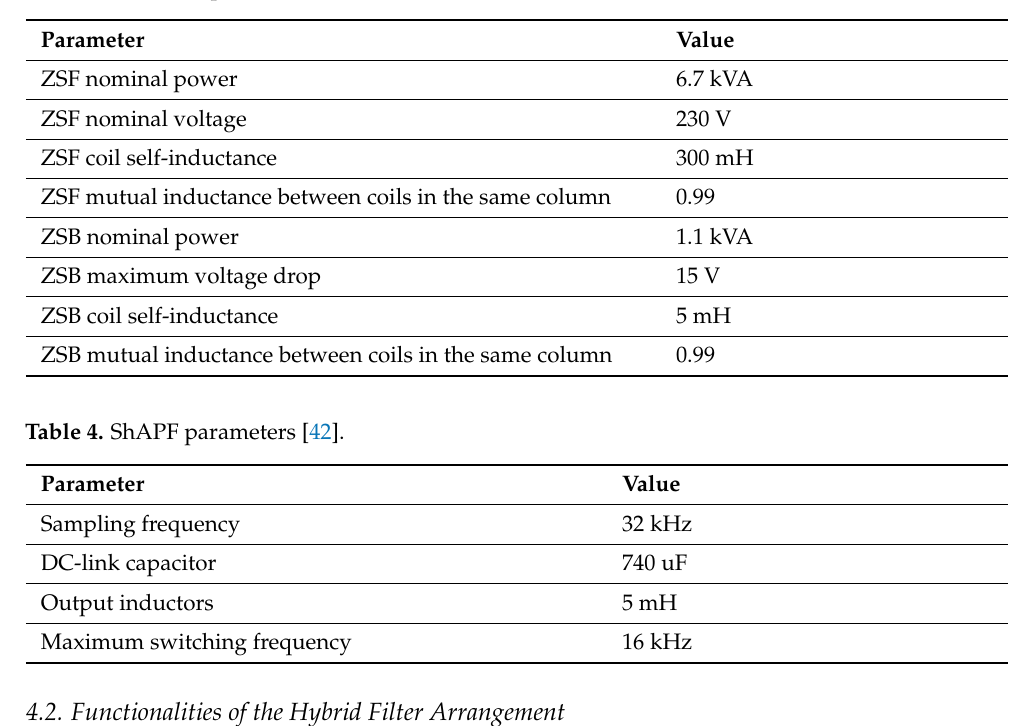
Table 3. ZSS main parameters.